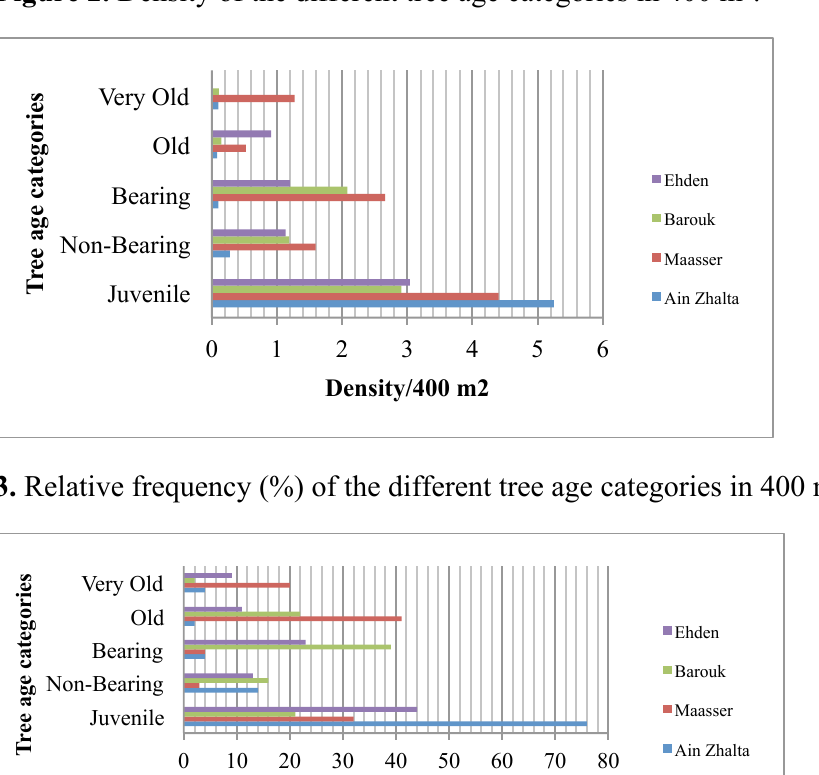
Figure 2. Density of the different tree age categories in 400 m 2 .